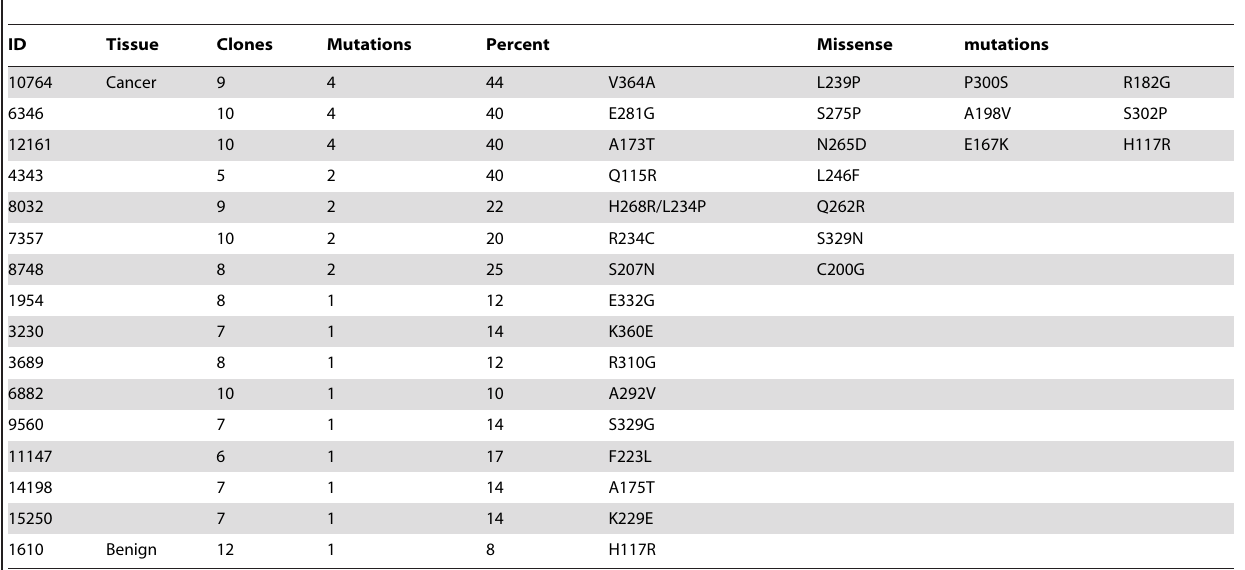
Table 2. Mutation analysis of the GTPase domain of GGAP2 in prostate cancer.